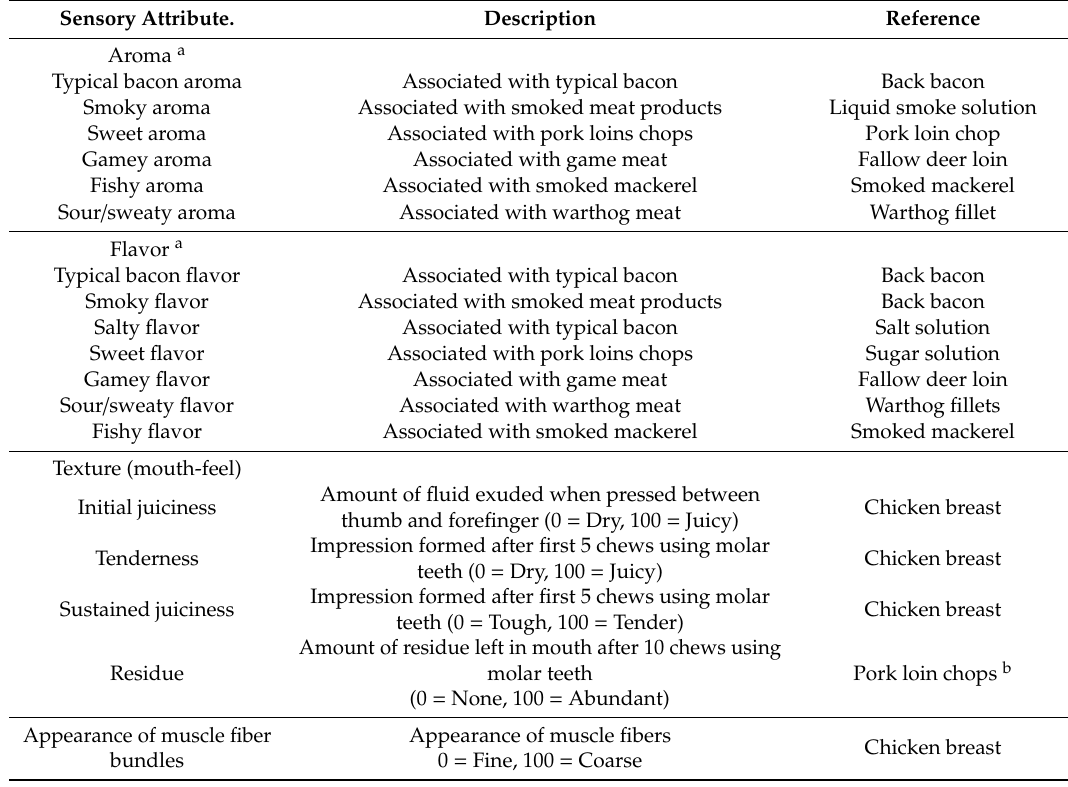
Table 3. Definition and scale of each attribute used for the descriptive sensory analysis of warthog back bacon. Sensory